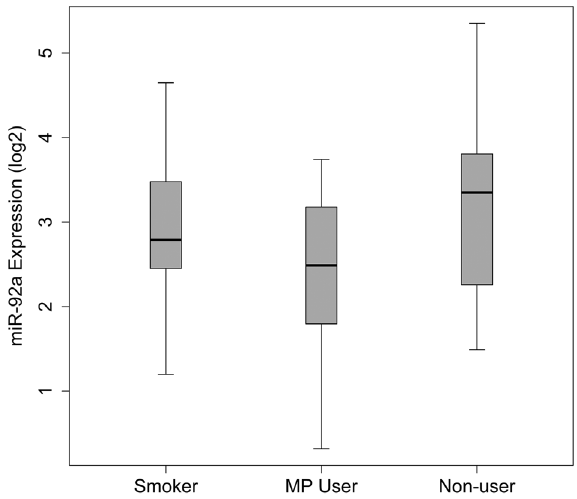
Figure 2- Boxplot of One-way Anova results for miR-92a